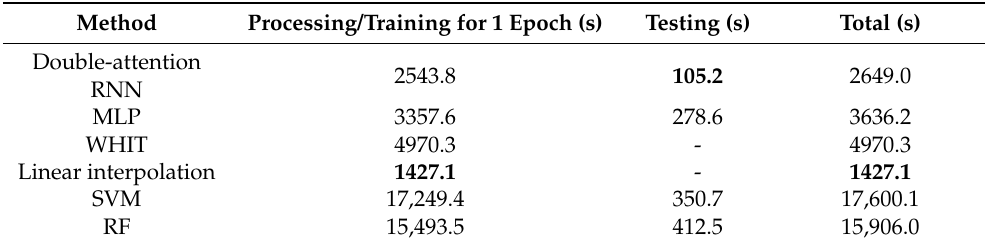
Table 3. Computational efficiency performance of comparative models. Bold numbers indicate the least time